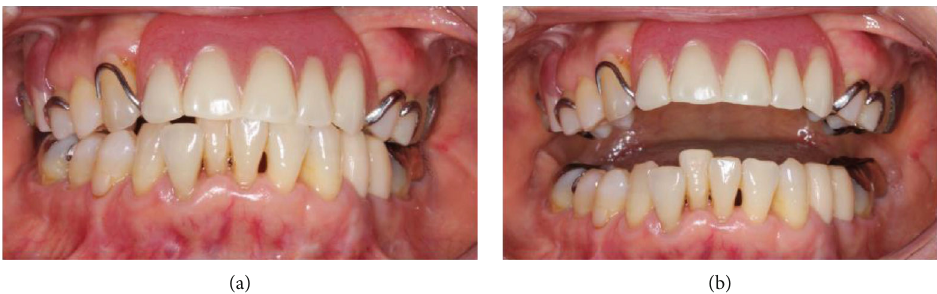
Figure 1: Preoperative views: (a) front view and (b) maximum mandibular opening at preoperation.